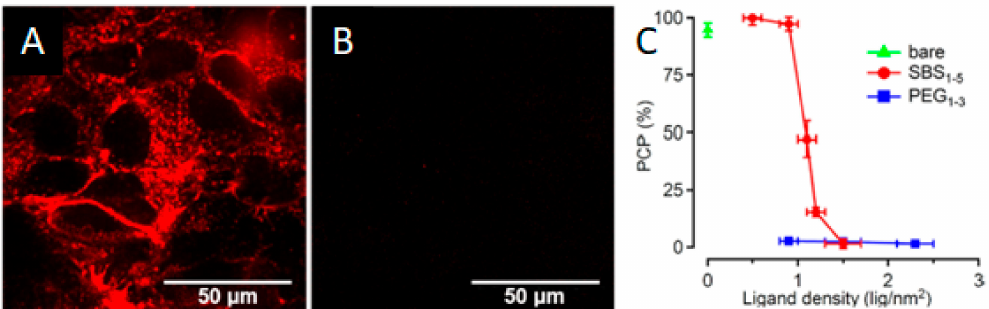
Figure 16. Fluorescence confocal microscopy images of zwitterion-functionalized quantum dots (QDs) ( A ) versus PEGylated QDs ( B ) and the correlation between a positive cell percentage (PCP) and ligand type and density ( C ). Reprinted with permission from reference [72]. Copyright (2019) American Chemical